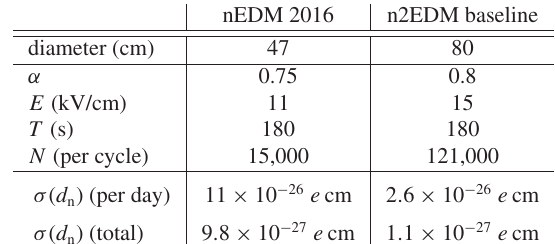
Table 1. Statistical sensitivity at 68% C.L. Comparison between the achieved performance of the previous apparatus and the estimate for n2EDM as described in the text. The total sensitivity estimate for nEDM 2016 is based on the total data acquired with the predecessor experiment until the end of 2016. The total sensitivity estimate for n2EDM is based on projected 500 days of measurement with about 280 cycles per day. PSI usually operates the proton beam and the UCN source on about 200 days per calendar